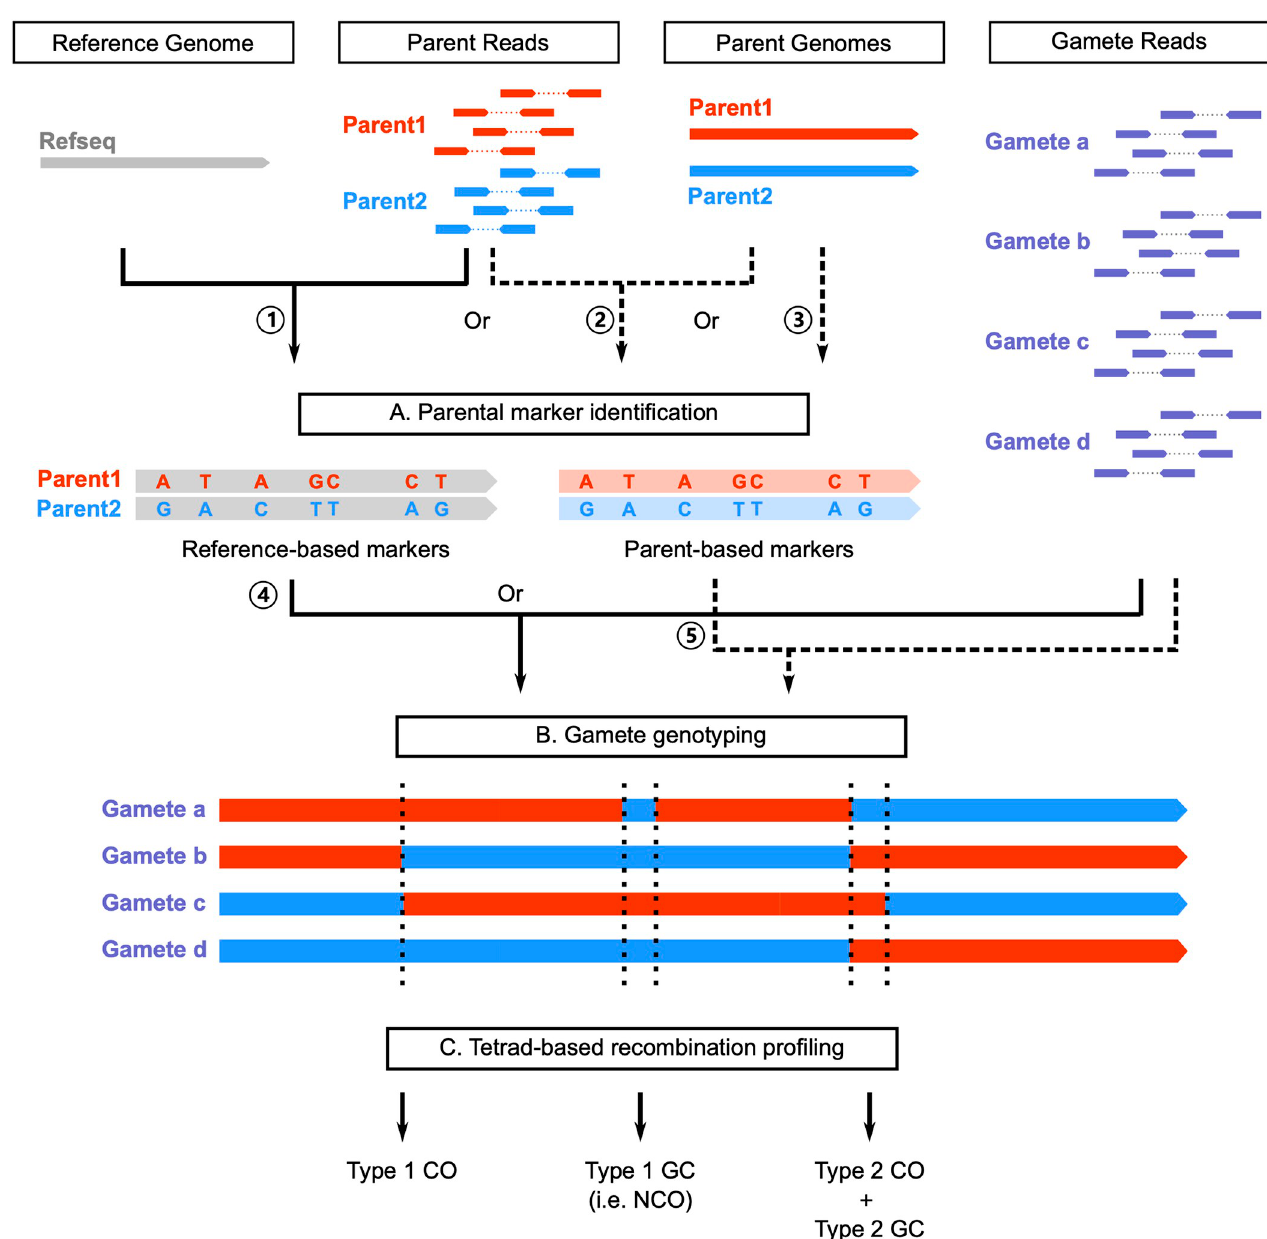
Fig 1. An overview of the RecombineX framework. RecombineX conduct sequencing-based tetrad analysis in three major phases: A) parental marker identification, B) gamete genotyping, and C) tetrad-based recombination profiling. Depending on the available input data, users can run RecombineX in either reference-based mode (denoted by solid arrows) or parent-based mode (denoted by dashed arrows). In the reference-based mode, parent reads are mapped to the reference genome for reference-based parental marker identification ( ① ), based on which gamete genotyping is further performed by evaluating the gamete-to-reference read mapping support at each marker position ( ④ ). The resulting genotyping assignments across the four gametes from the same tetrad are jointly evaluated for profiling recombination events based on the reference genome coordinate system. In the parent-based mode, whole genome alignment is firstly constructed based on the native genome assemblies of the two crossing parents, upon which parent-based markers are identified accordingly ( ③ ). Optionally, parent-based markers obtained from whole genome alignment can be further leveraged by reciprocal parent-based read mapping ( ② ). In either case, gamete genotyping is performed by evaluating the gamete-to-parent read-mapping at each marker position( ⑤ ). The resulting genotyping assignments across the four gametes from the same tetrad are jointly evaluated for profiling recombination events based on the coordinate systems of the two parental genome